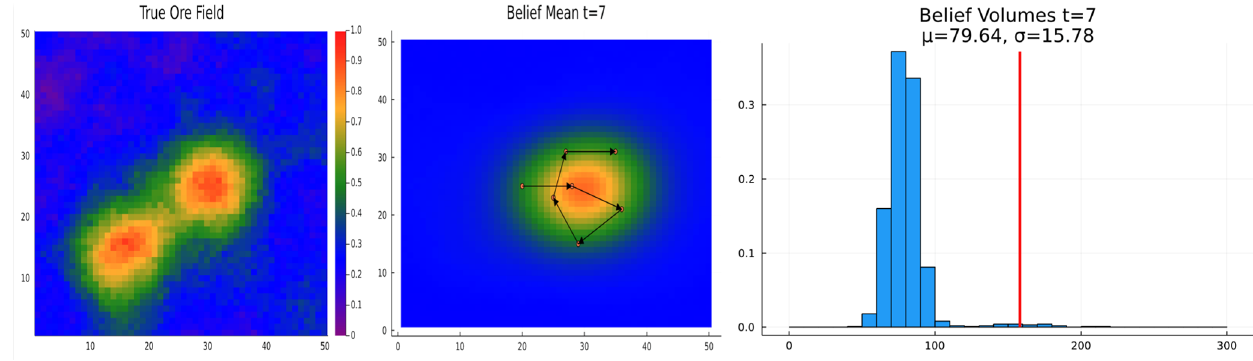
Figure 33. Multi-body failure example. This figure shows an example of an incorrect ABANDON decision made based on the multi-body case. In this trial, the belief converged too quickly to a sub-economic case with a single ore body before resolving the second ore body in the